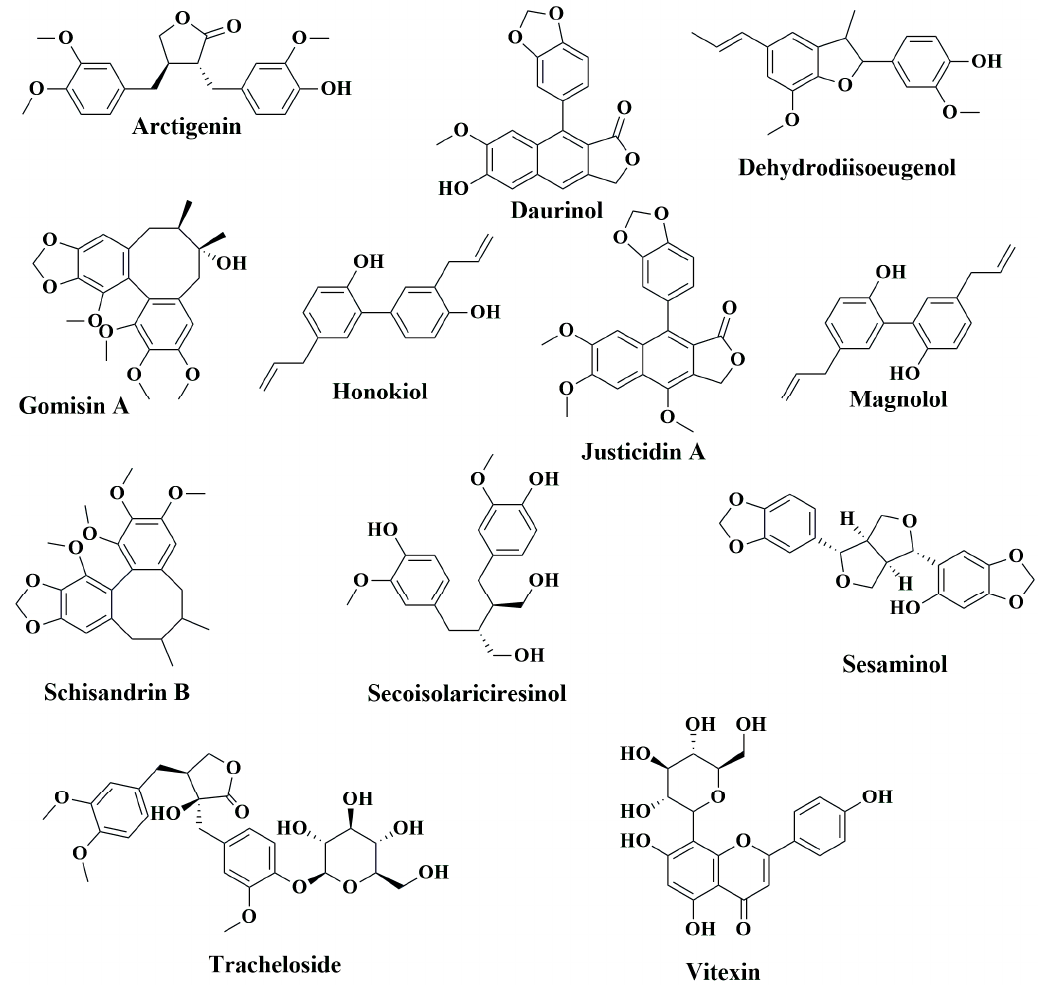
Figure 4. Chemical structures of lignans with in vivo anti-CRC activities.